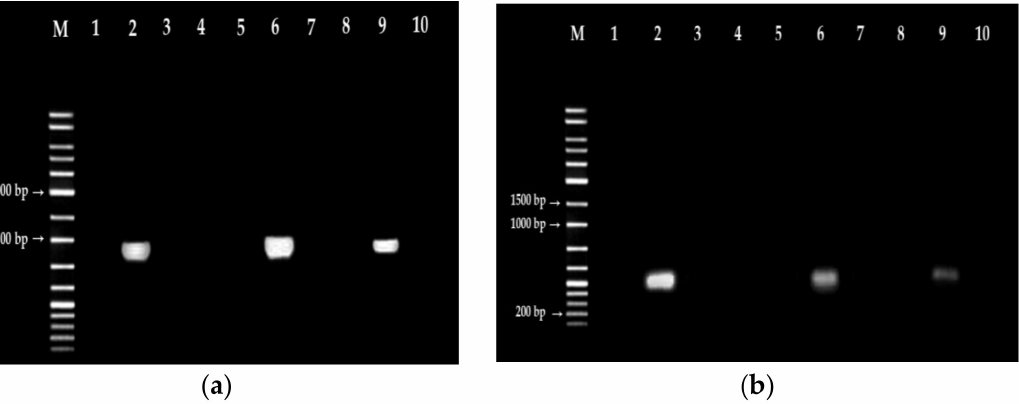
Figure 8. Agarose gel electrophoresis showing: PCR detection for NDM ( a ) and IPM ( b ) genes. K.